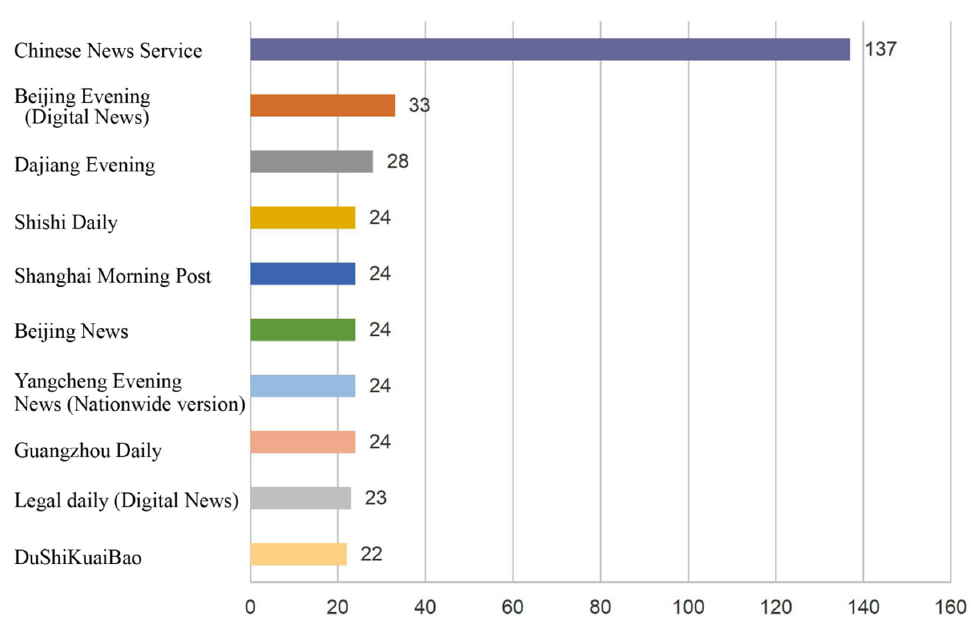
Figure 7. The most represented media sources for the collected news reports (N = 2886).